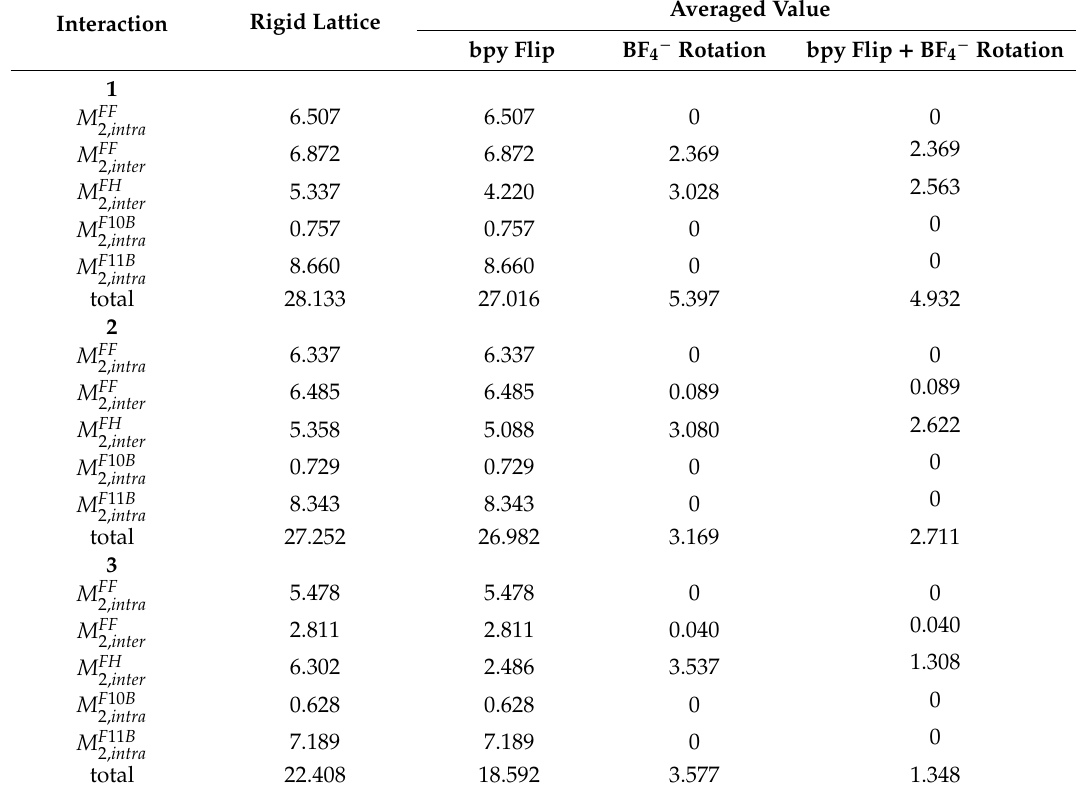
Table A2. 19 F second moments (in 10 − 8 T 2 ) for all ELM-11